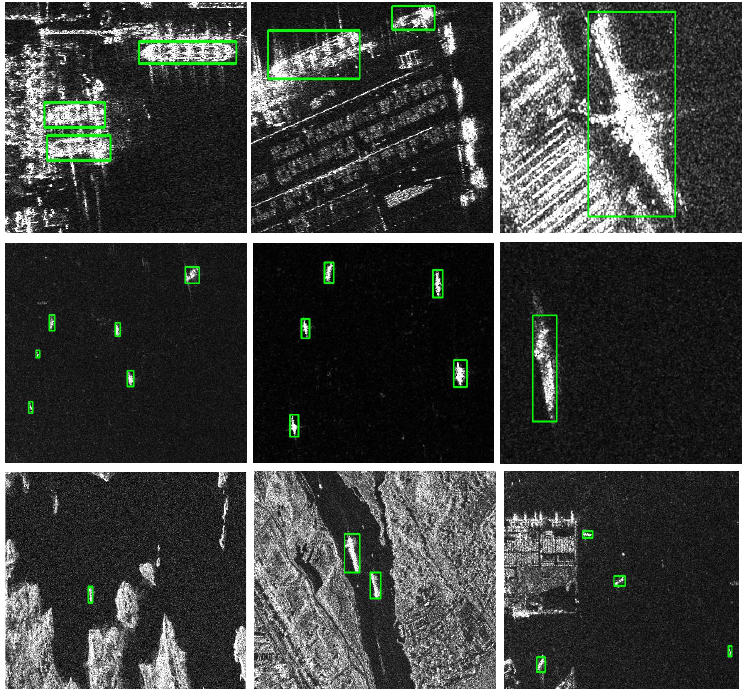
Figure 5. Sample images from the SAR ship detection dataset (SSDD) dataset. The SSDD dataset contains ships in different scenes: The first row shows the scene where the ship is inshore, the second row shows the scene where the ship is offshore, and the third row shows a complex scene with a large field of view.